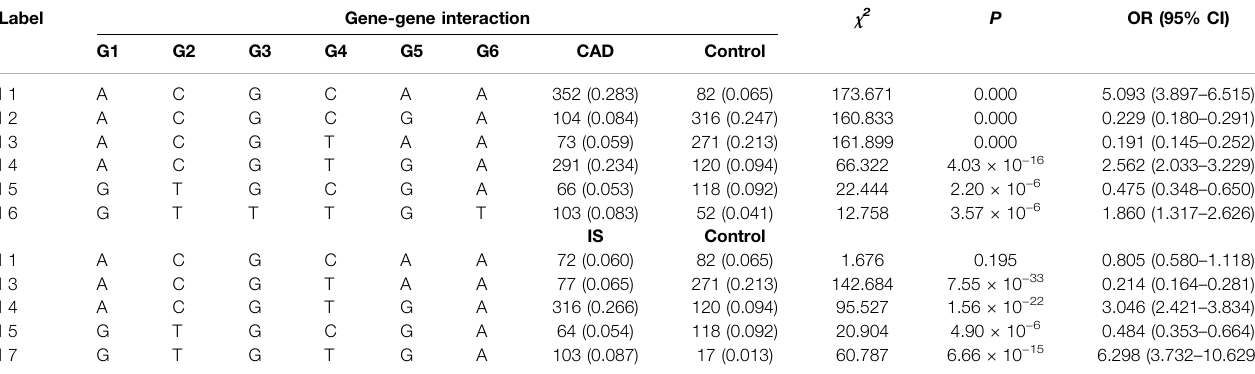
TABLE 7 | Frequencies of gene-gene interactions in the control and disease groups [ n (frequency)]. Label Gene-gene